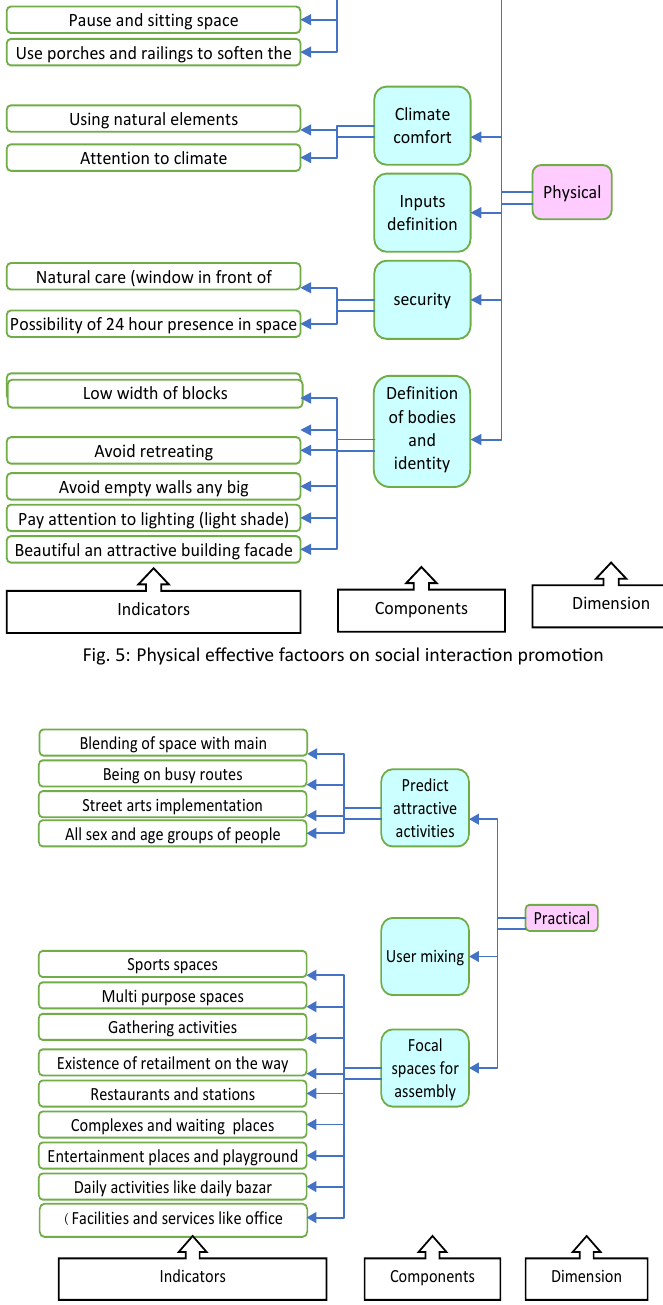
Fig. 6: Effective practical factors on social interaction promotion